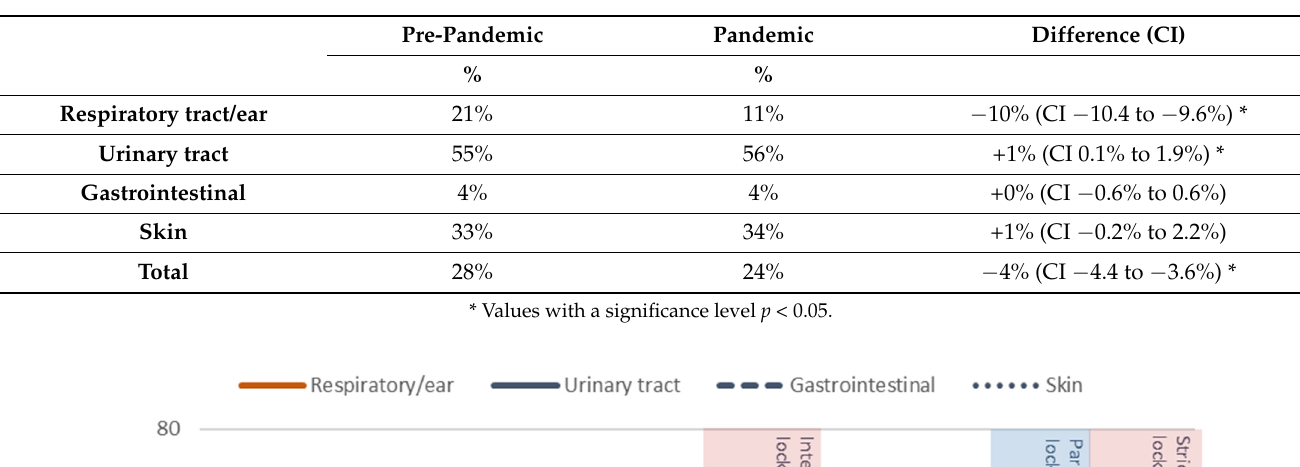
Table 2. Prescription rates for common infections pre-pandemic and during the complete first pandemic year.